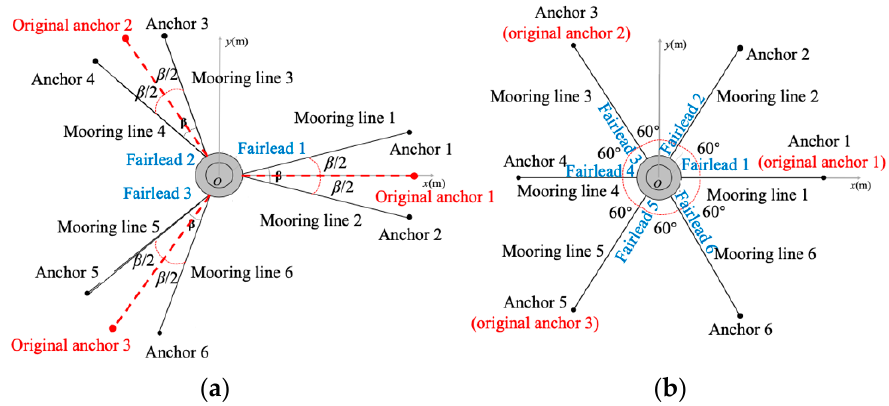
Figure 6. Developed mooring systems with ( a ) three fairleads and ( b ) six fairleads.